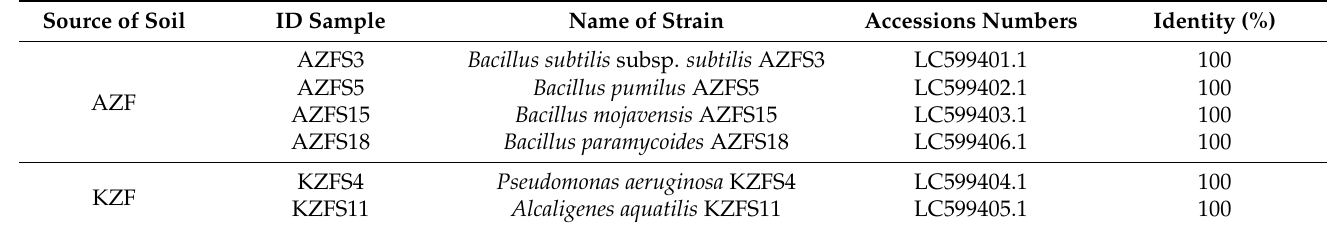
Table 4. Results of identification processes due to analysis of 16S rRNA gene sequencing of four Bacillus strains , Alcaligenes , and Pseudomonas strains isolated from soil contaminated with